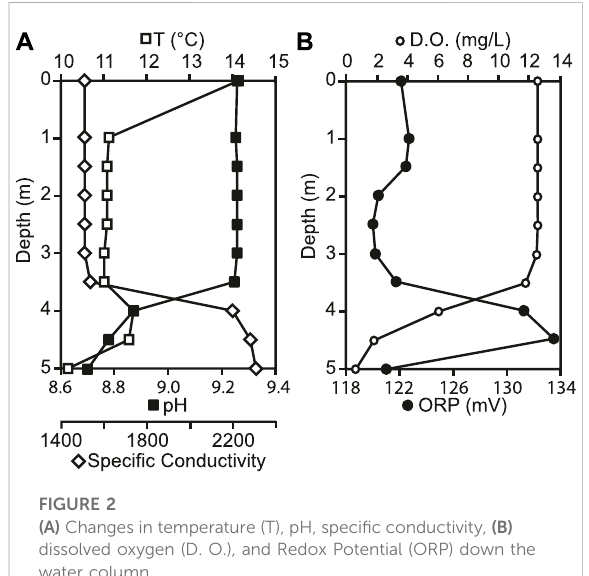
FIGURE 2 (A) Changes in temperature (T), pH, speci fi c conductivity, (B) dissolved oxygen (D. O.), and Redox Potential (ORP) down the water